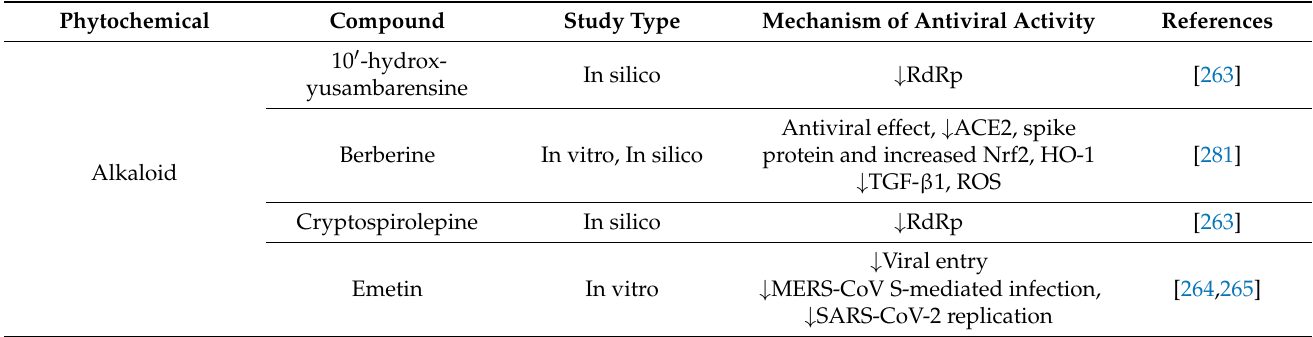
Table 1. Candidate phytochemicals with promising antiviral effects.